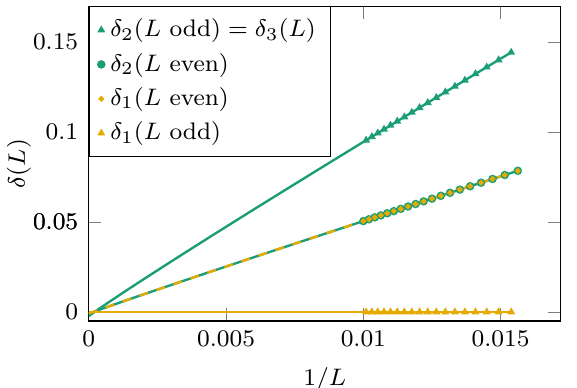
to the n -th excited states from system sizes n